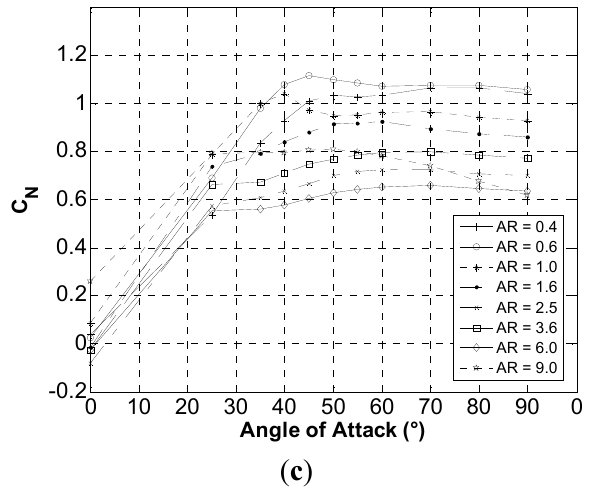
Figure 8. ( a ) Drag; ( b ) lift; and ( c ) normal coefficient at minimum clearance as a function of AR and α .